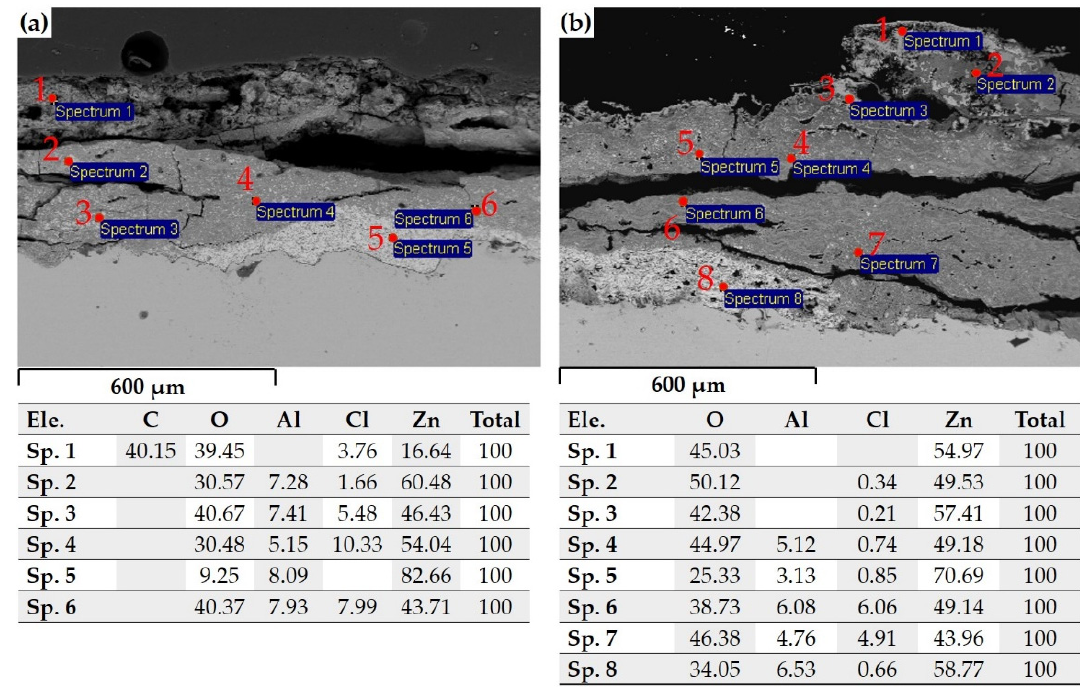
Figure 17. SEM-images of corroded coatings: ( a ) in compressed air sprayed coatings and ( b ) in argon sprayed coatings.